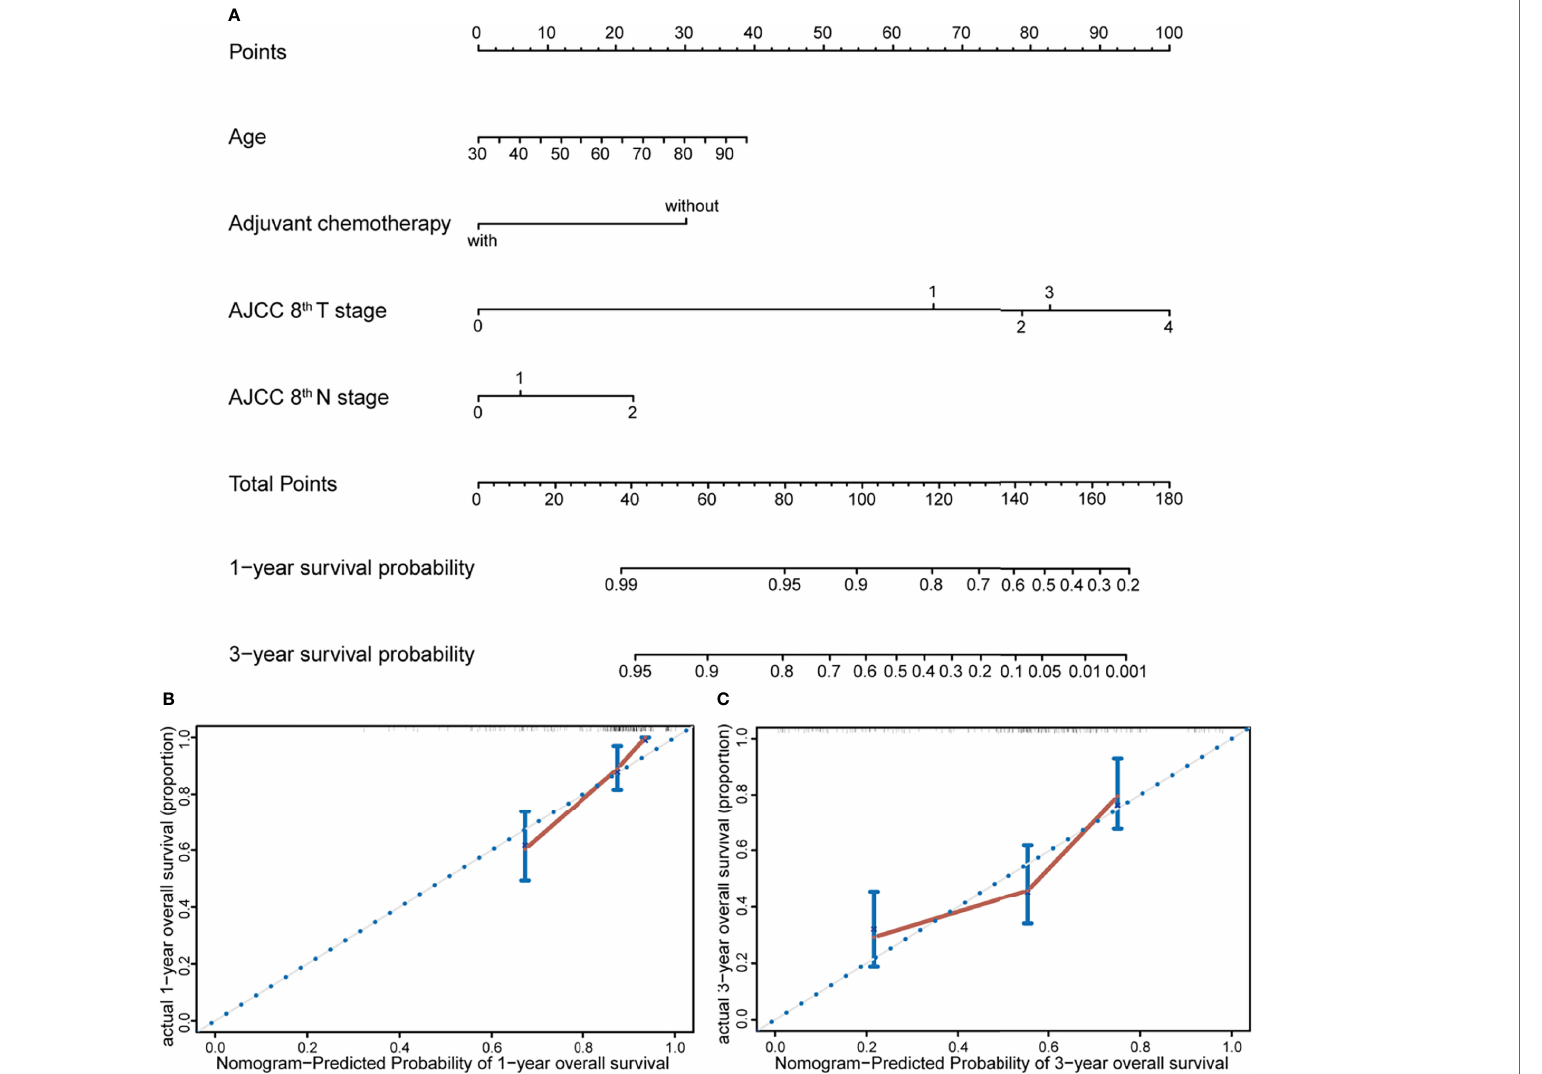
FIGURE 2 | Nomogram and calibration plot for prediction of 1- and 3-year survival. (A) Prognostic nomogram for predicting survival probabilities of PDAC patients who received radical resection, constructed by age, reception of adjuvant chemotherapy, and AJCC 8th T and N stage. The 1- and 3-year survival probability could be predicted according to the total points, which were calculated by the summation of each factor ’ s points from the points scale. (B, C) Calibration plot of the prognostic nomogram for 1- and 3-year survival, respectively. The nomogram was subjected to 1,000 bootstrap resamples for internal validation of the cohort, and the accuracy of this model could be demonstrated by comparing the actual and predicted probabilities of overall